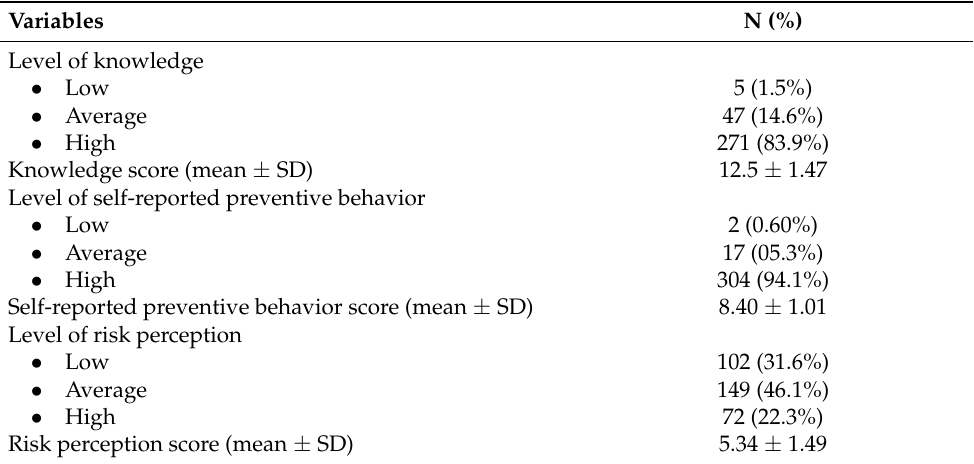
Table 4. Level of knowledge, self-reported preventive behavior, and risk perception regarding COVID-19 ( n =